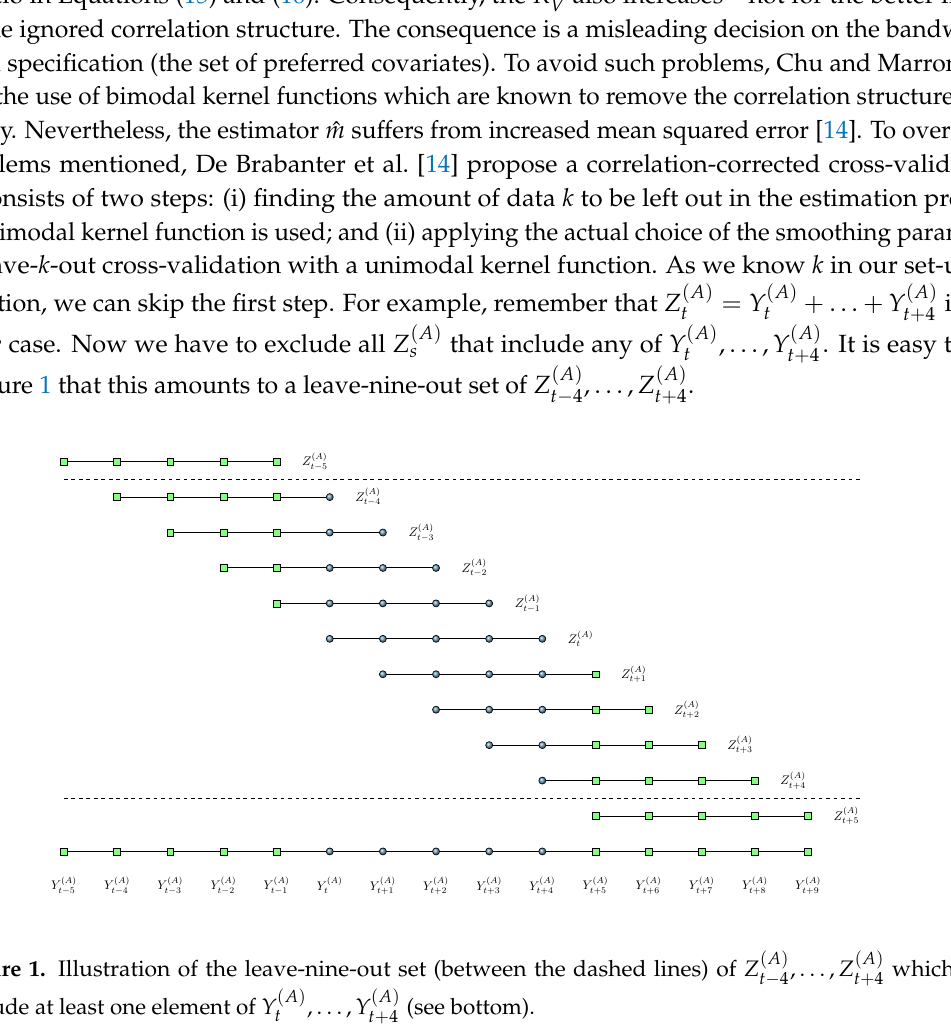
( A ) ( A ) , . . . , Y (see t t + 4